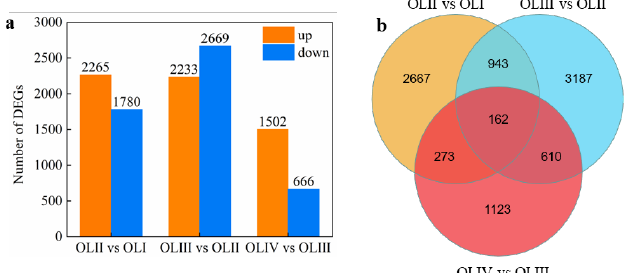
Figure 2. Numbers of DEGs in diverse pairwise comparisons ( a ) and Venn diagram showing the common and unique DEGs among different pairwise comparisons ( b ). Detailed information on the significant DEGs is presented in Tables S2 – S4.